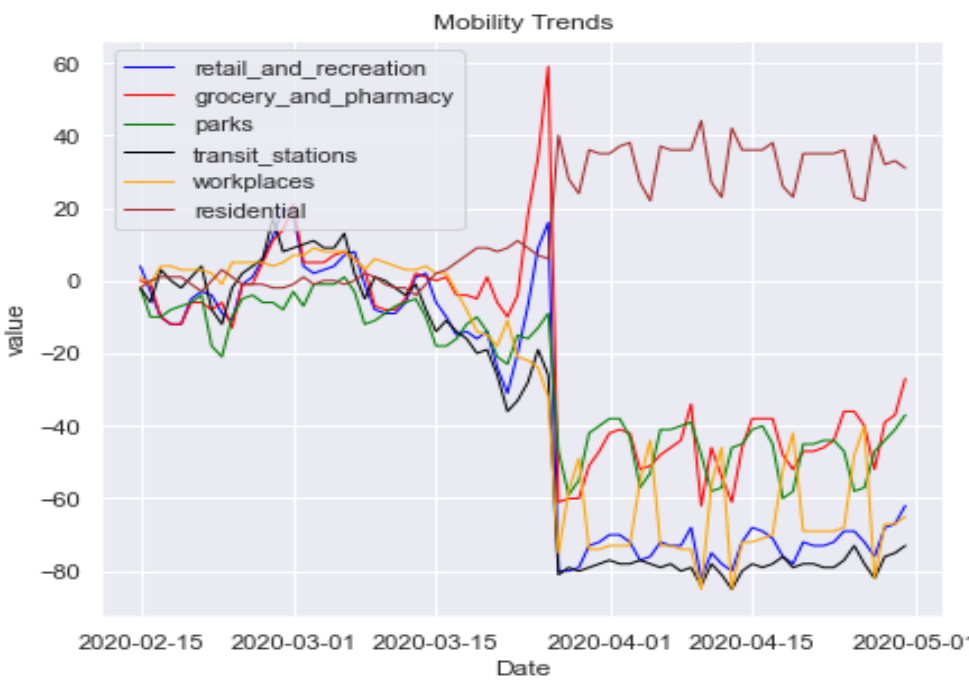
Figure 2. Plots of the datasets for the 6 categories of